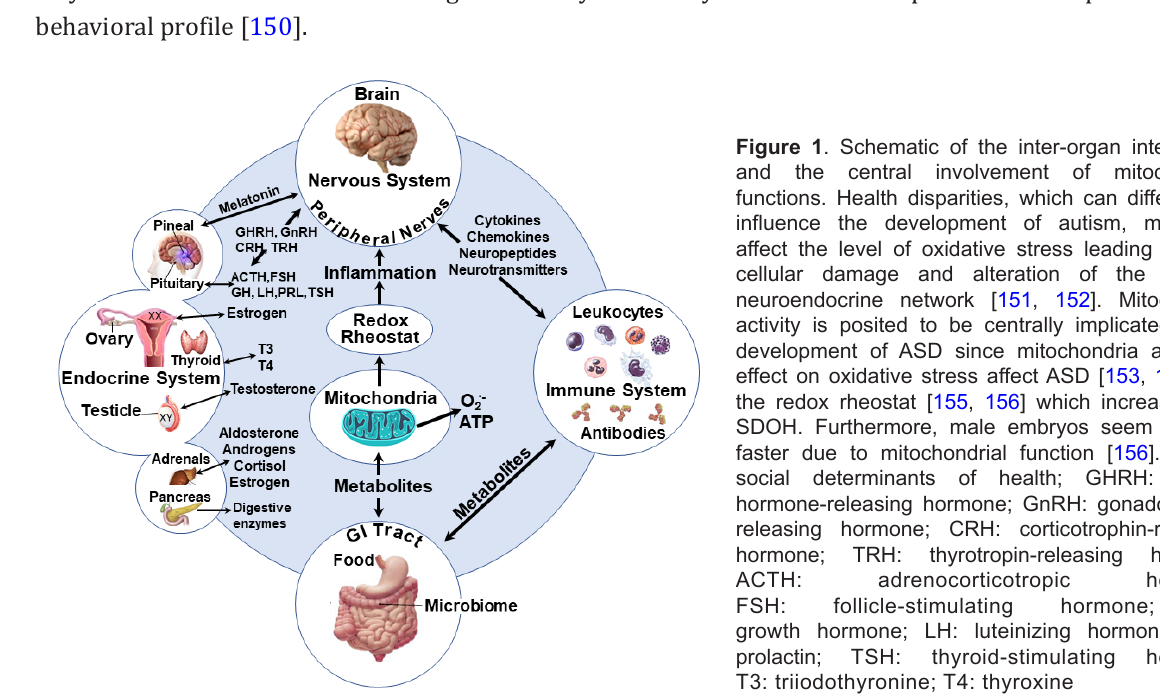
Figure 1 . Schematic of the inter-organ interactions and the central involvement of mitochondrial functions. Health disparities, which can differentially influence the development of autism, may also affect the level of oxidative stress leading to more cellular damage and alteration of the immune neuroendocrine network [151 , 152 ] . Mitochondria activity is posited to be centrally implicated in the development of ASD since mitochondria and their effect on oxidative stress affect ASD [153, 154 ] and the redox rheostat [ 155 , 156] which increases with SDOH. Furthermore, male embryos seem to grow faster due to mitochondrial function [ 156 ]. SDOH: social determinants of health; GHRH: growth hormone-releasing hormone; GnRH: gonadotrophin- releasing hormone; CRH: corticotrophin-releasing hormone; TRH: thyrotropin-releasing hormone; ACTH: adrenocorticotropic hormone; FSH: follicle-stimulating hormone; GH: growth hormone; LH: luteinizing hormone; PRL: prolactin; TSH: thyroid-stimulating hormone; T3: triiodothyronine; T4: